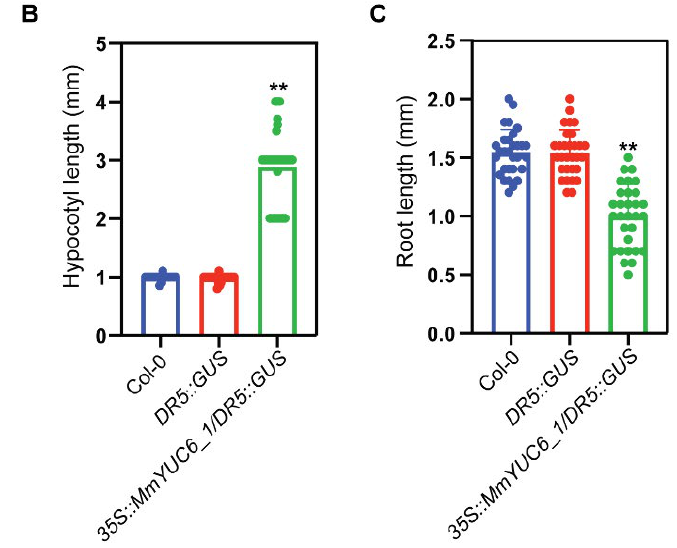
Figure 6. Phenotype of DR5::GUS and 35S::MmYUC6_1/DR5::GUS plants. ( A ) Phenotypes of 7-days- old seedlings. Bar scale, 5 mm. ( B ) Quantification analysis of the hypocotyl lengths of DR5::GUS and 35S::MmYUC6_1/DR5::GUS seedlings (n = 30). ( C ) Quantification analysis of the root lengths of DR5::GUS and 35S::MmYUC6_1/DR5::GUS seedlings (n = 30). ** represents the significant difference